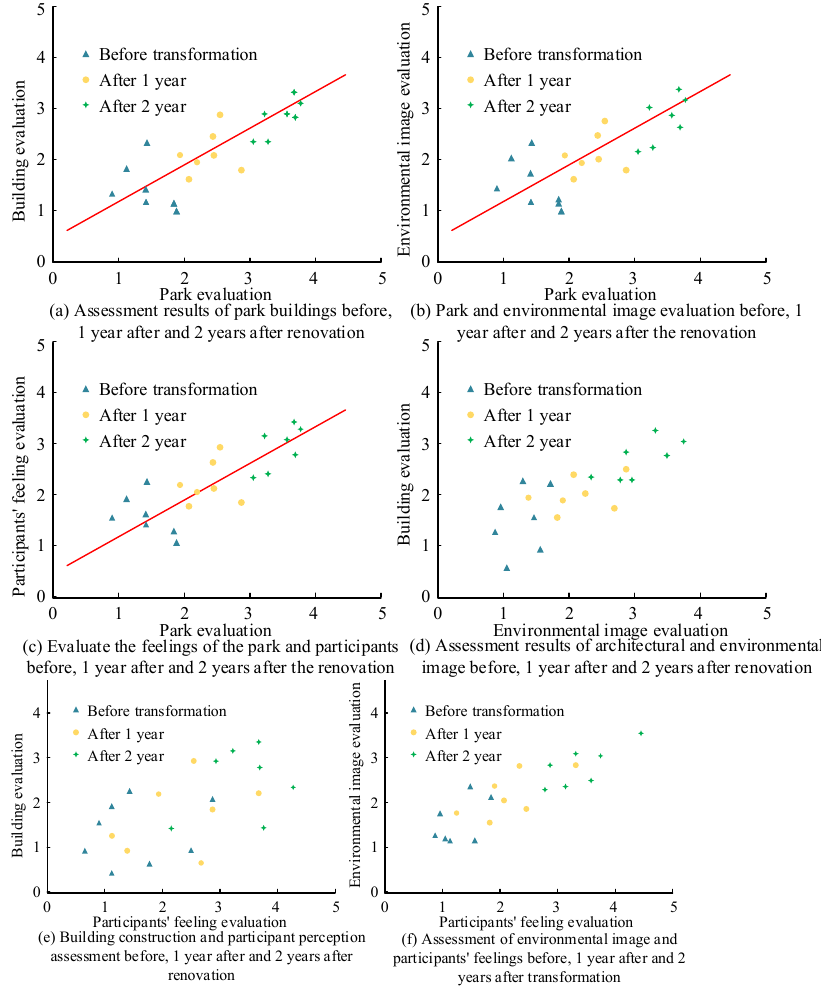
Figure 9. Correlation of Four Intermediate Index Levels in the Regenerative Landscape Design of Kailuan System Industrial Heritage.